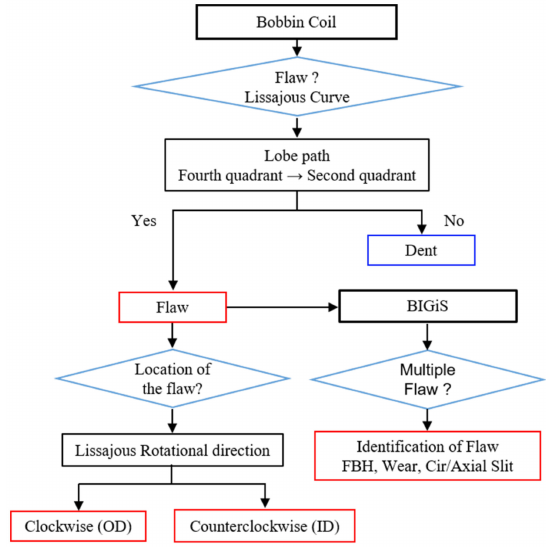
Figure 19. The flaw classification